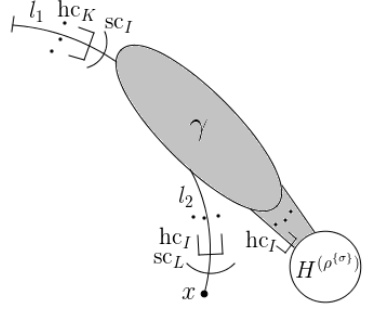
T J ( (cid:26) f (cid:27)n:::(cid:27) 1 g ) Figure 15. The subgraph (cid:13) (cid:17) J ( (cid:27) i ) , which includes the propagators marked by I K momentum l (cid:22) as well as the shaded area. The combinations of hard-collinear and soft-collinear 2 approximations are given by t (cid:27) : : : t (cid:27) . n 1